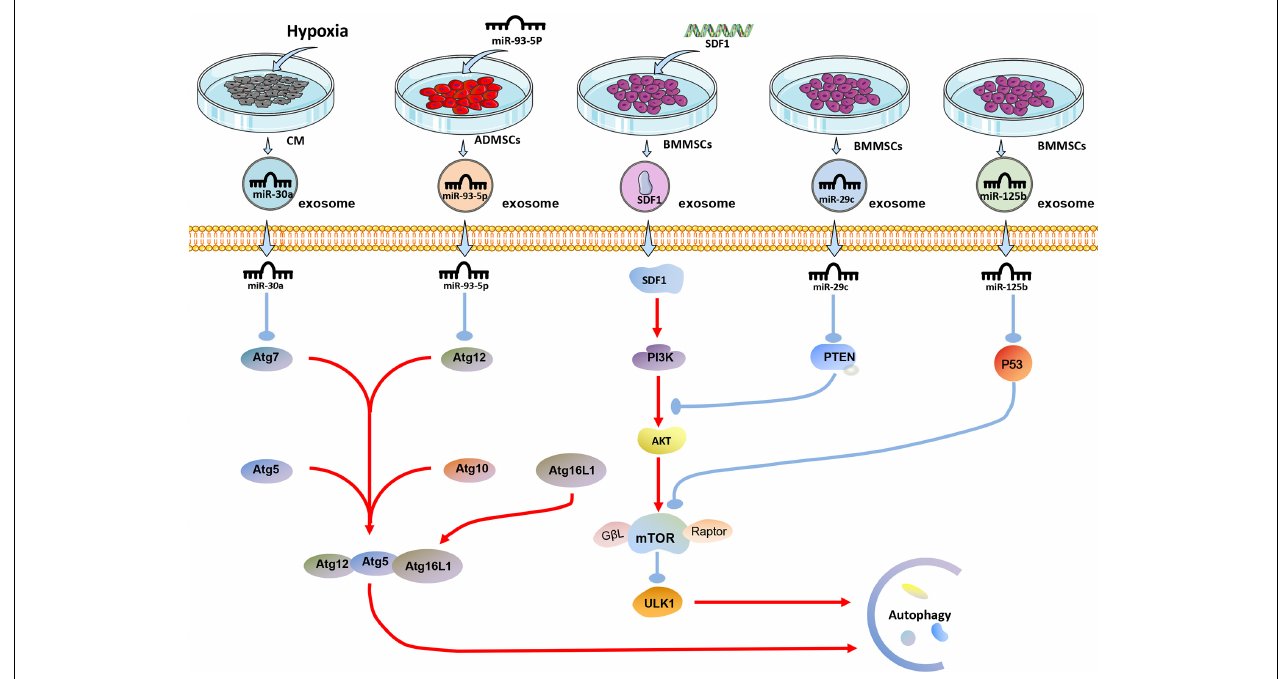
FIGURE 2 | The effect of exosomes derived from differently treated cells on autophagy of cardiomyocytes after MI. The miR-30a in exosomes secreted by cardiomyocytes after hypoxia is targeted to Atg7 for anti-autophagy; miR-93-5P in exosomes secreted by ADMSCs transfected with miR-93-5P targeted Atg12 for anti-autophagy; SDF1 protein secreted by BMMSCs transfected with SDF gene activates PI3K/AKT pathway to resist autophagy; miR-29c and miR-125b in exosomes derived from BMMSCs target PTEN and P53, respectively, to resist autophagy.